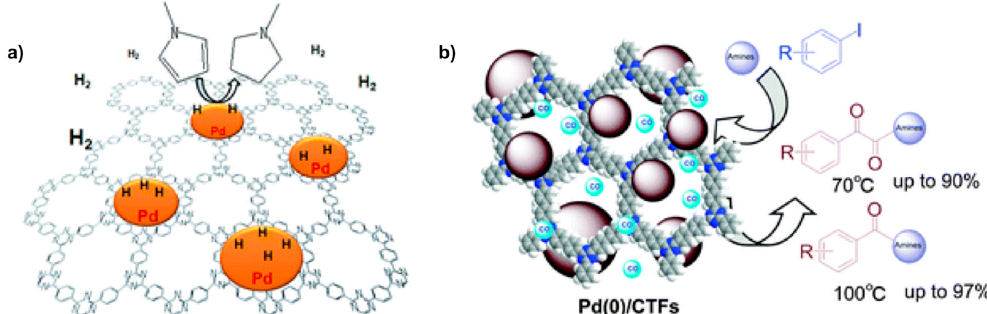
Figure 2. Schematic picture of ( a ) Pd/CTF catalyzed hydrogenation of N -heterocycles (Reproduced with